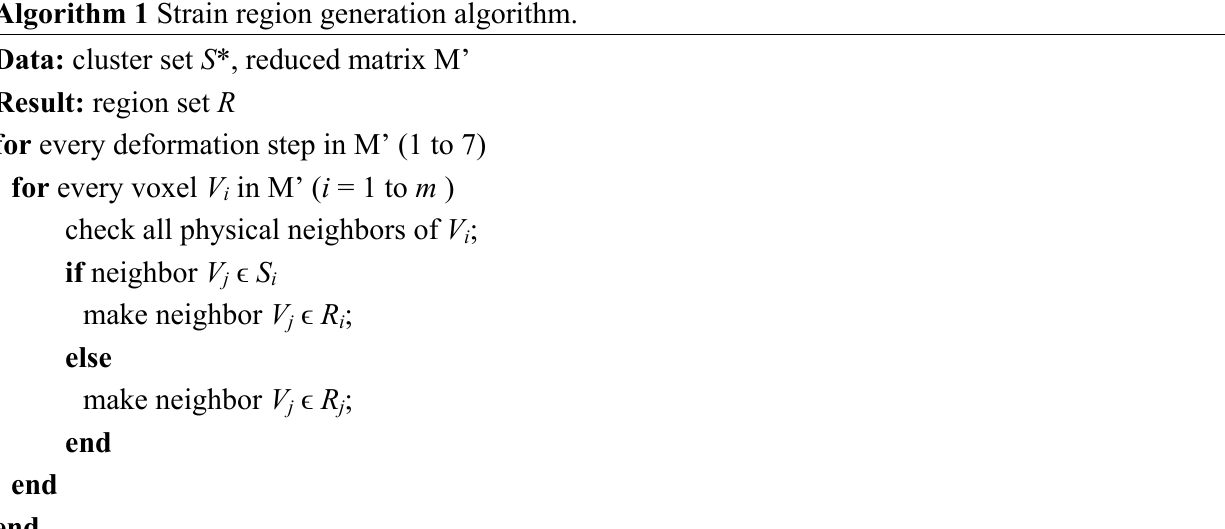
Algorithm 1 Strain region generation